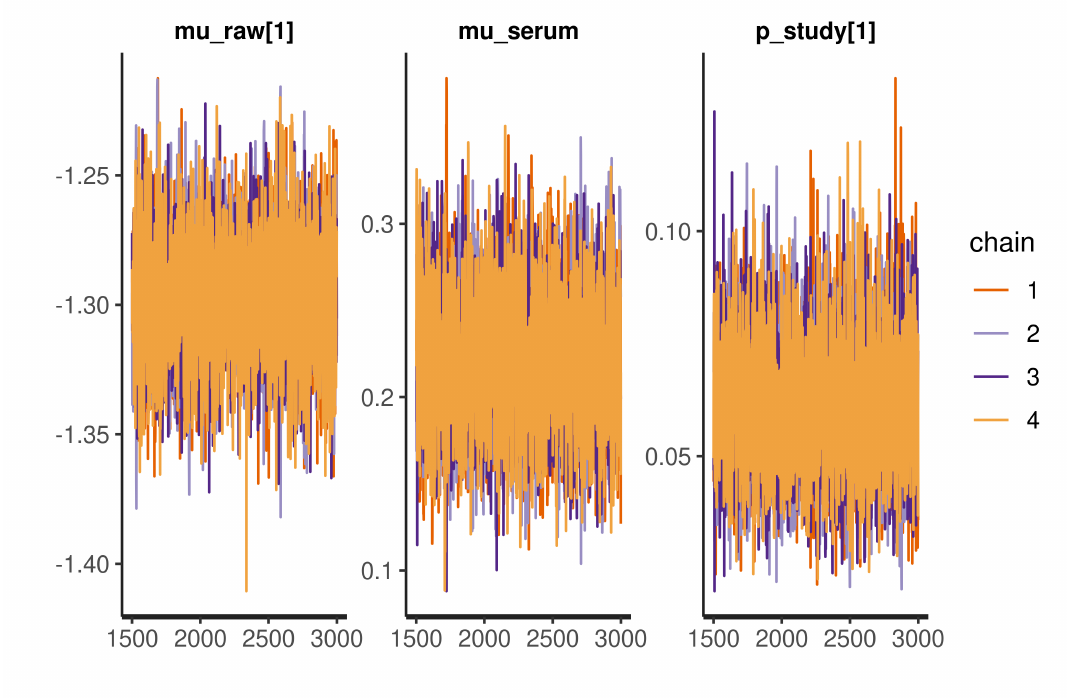
Figure A1. Traceplot of selected parameters, the uniform spread of the values and absence of ‘wandering’ chains indicates proper